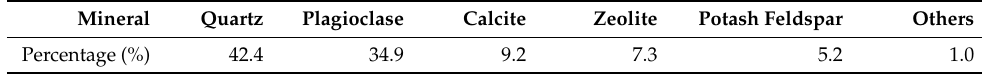
Figure 1. Red sandstone. Table 1. Mineral composition of red sandstone.